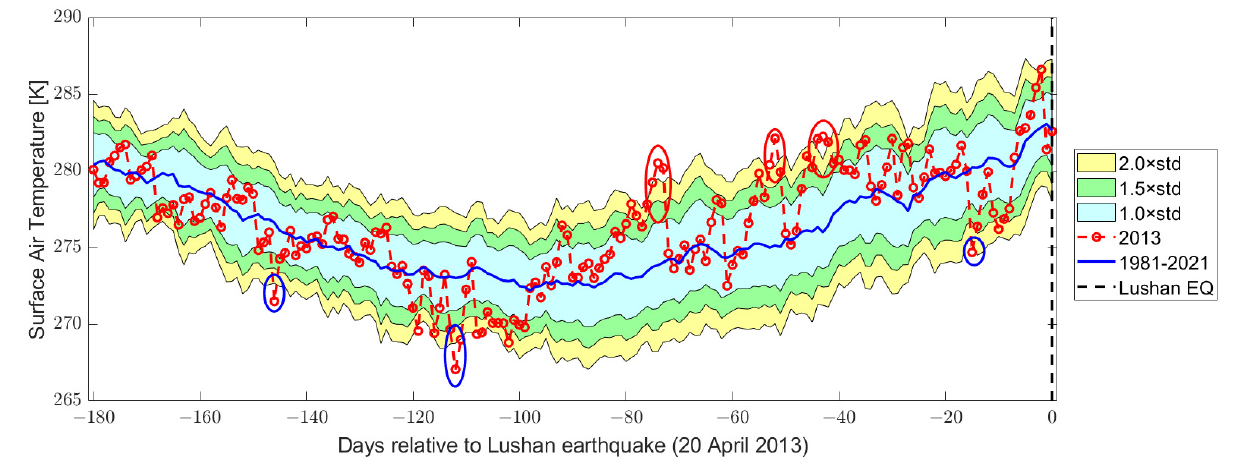
Figure 11. Surface Air temperature from the six months before the Mw 6.7 Lushan 2013 earthquake.